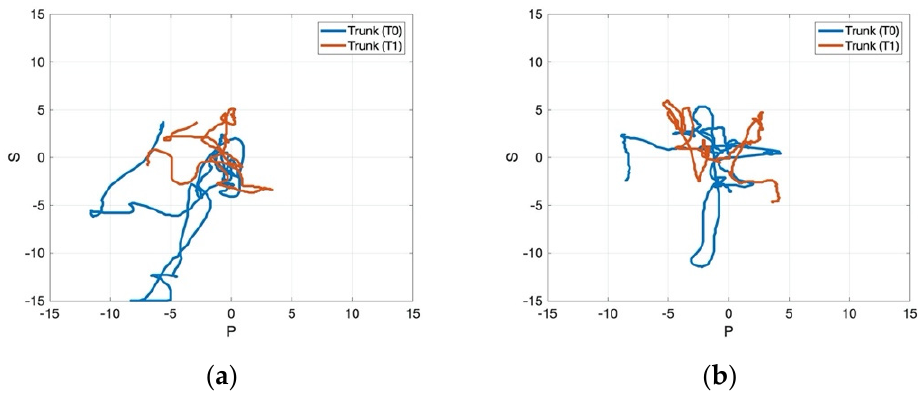
Figure 6. Trunk stabilometric assessment for one representative patient in the control group ( a ) and experimental group ( b ) pre- and post-treatment. Abbreviations: T0: pre-treatment; T1: post-treat- ment.